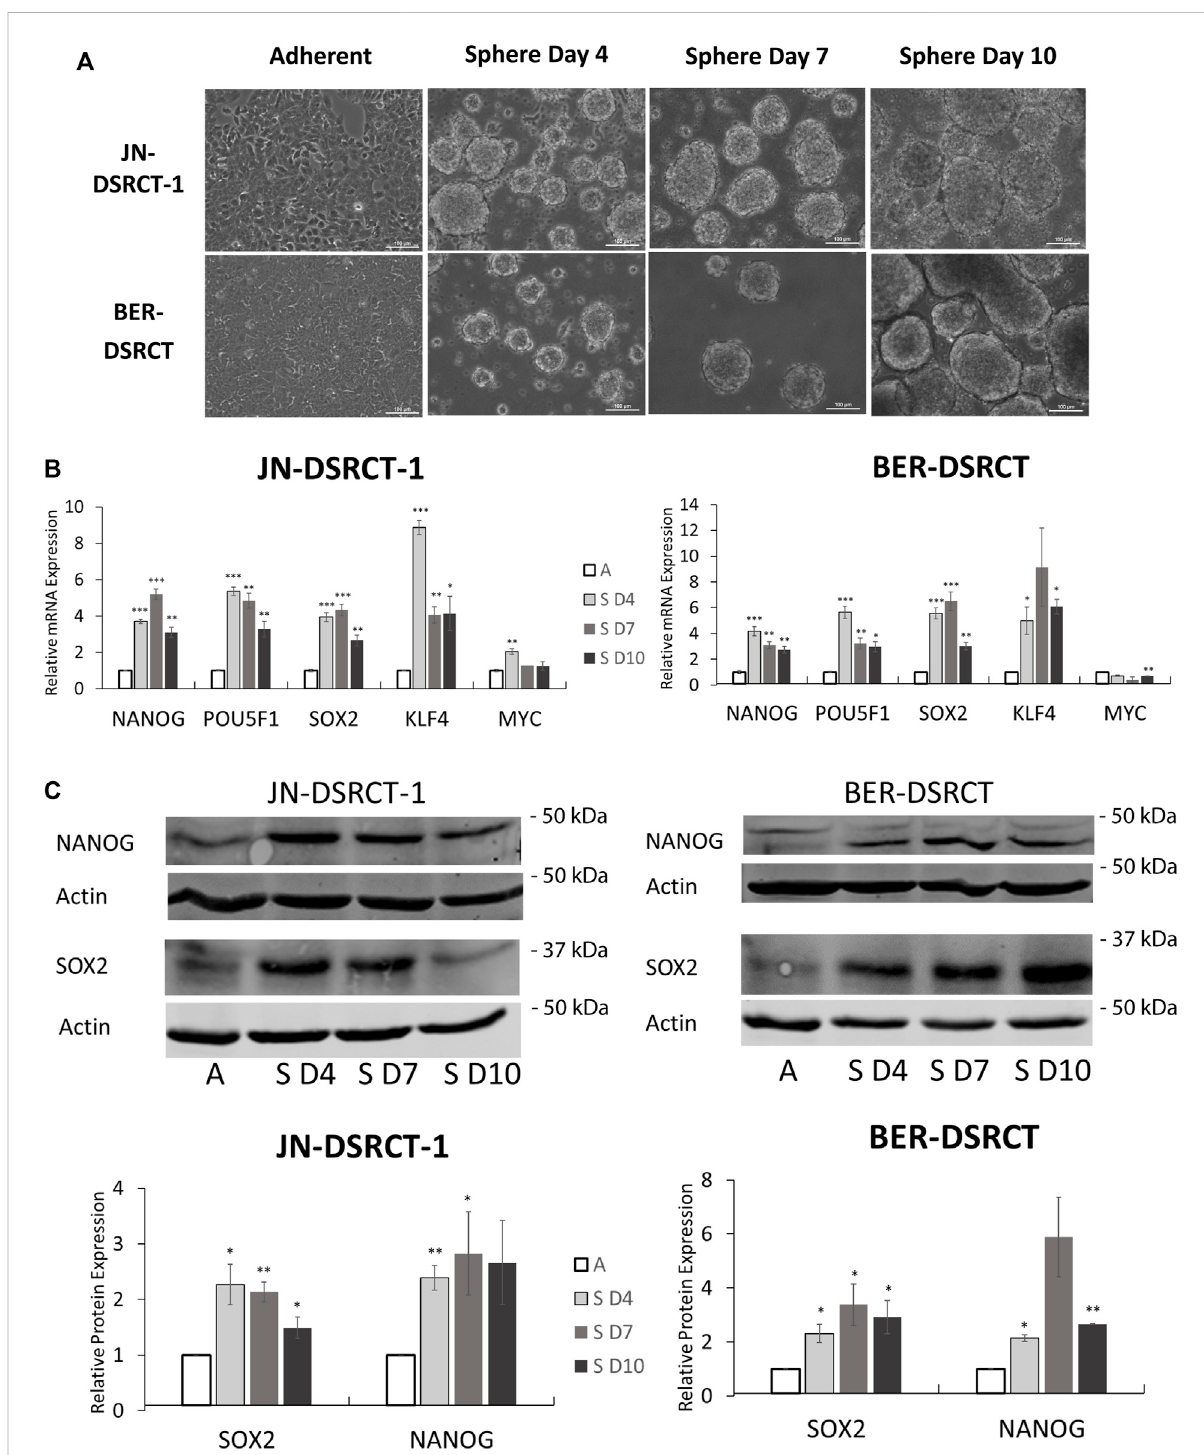
Tumorsphere formation increases stemness expression in vitro . (A) Light microscopy images of JN-DSRCT-1 and BER-DSRCT cells grown in adherentcultureorsphereculturefor4,7,and10 days. (B) Relativeexpressionof NANOG , POU5F1 , SOX2 , KLF4 ,and MYC mRNAsinadherentculture (A) , 4 days of sphere culture (S D4), 7 days of sphere culture (S D7), or 10 days of sphere culture (S D10) assessed via RT-qPCR ( n = 3, * p < 0.05, ** p < 0.01, *** p < 0.001, Student ’ s t -test). (C) Western blot of NANOG and SOX2 protein expression in adherent culture or 4, 7, or 10 days of